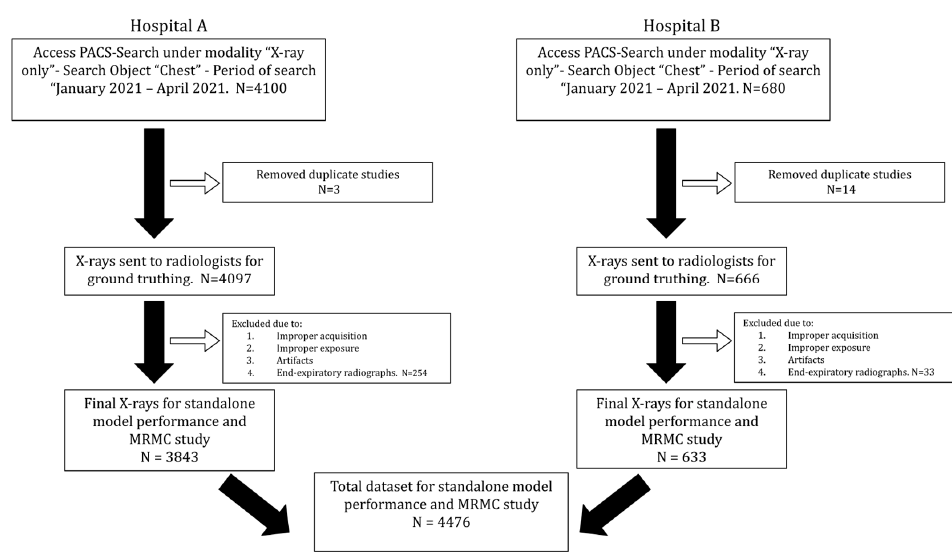
Figure 1. Flowchart illustrating inclusion and exclusion criteria used to select chest radiographs for standalone model performance and multi-reader multi-case (MRMC) study.